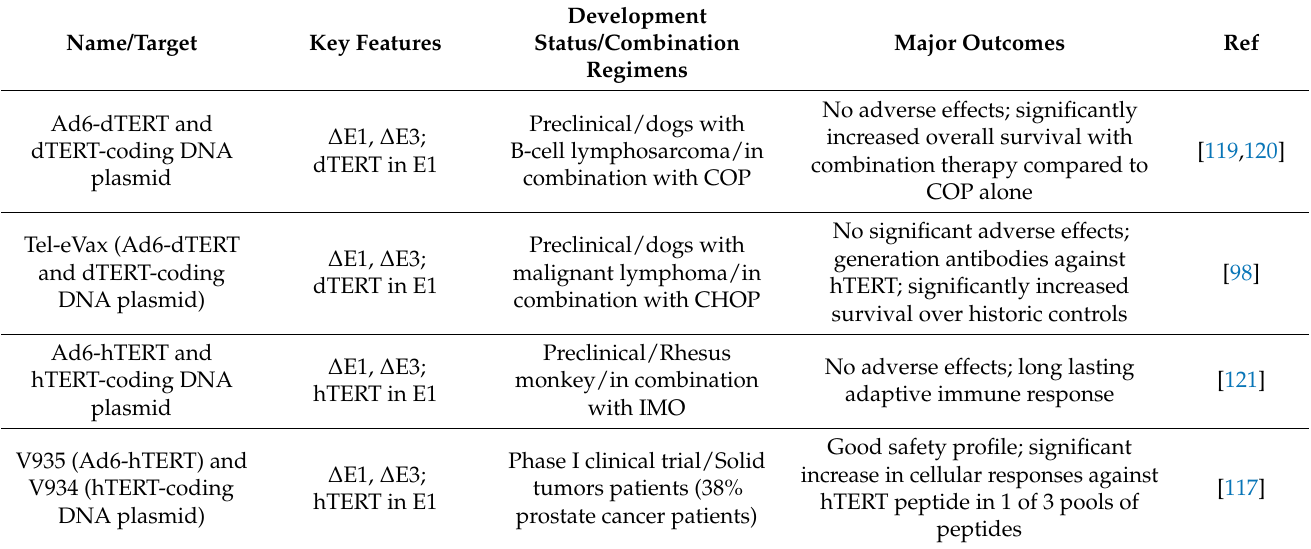
Table 3. Ad6-based anti-cancer